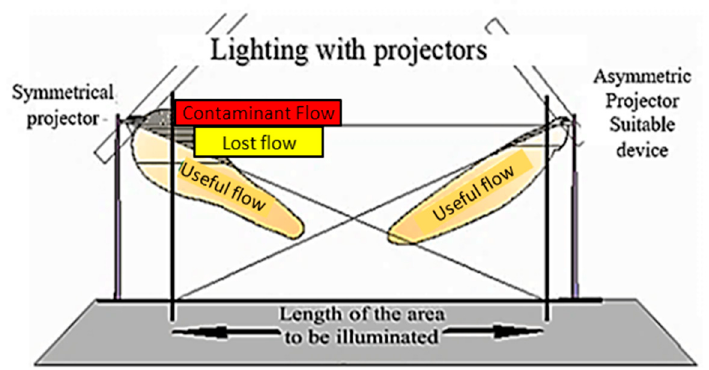
Figure 5. Difference between an asymmetric and a symmetric projector representation.